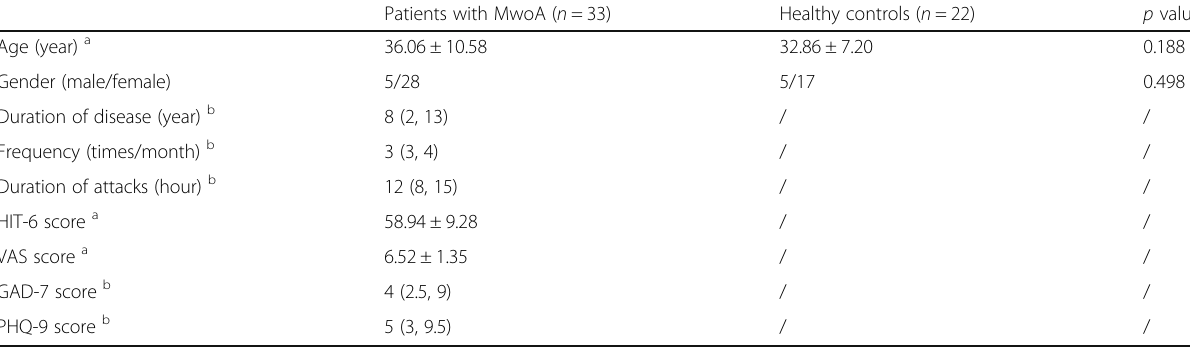
Table 1 Characteristics of patients with MwoA and healthy contrasts Patients with MwoA ( n = 33)